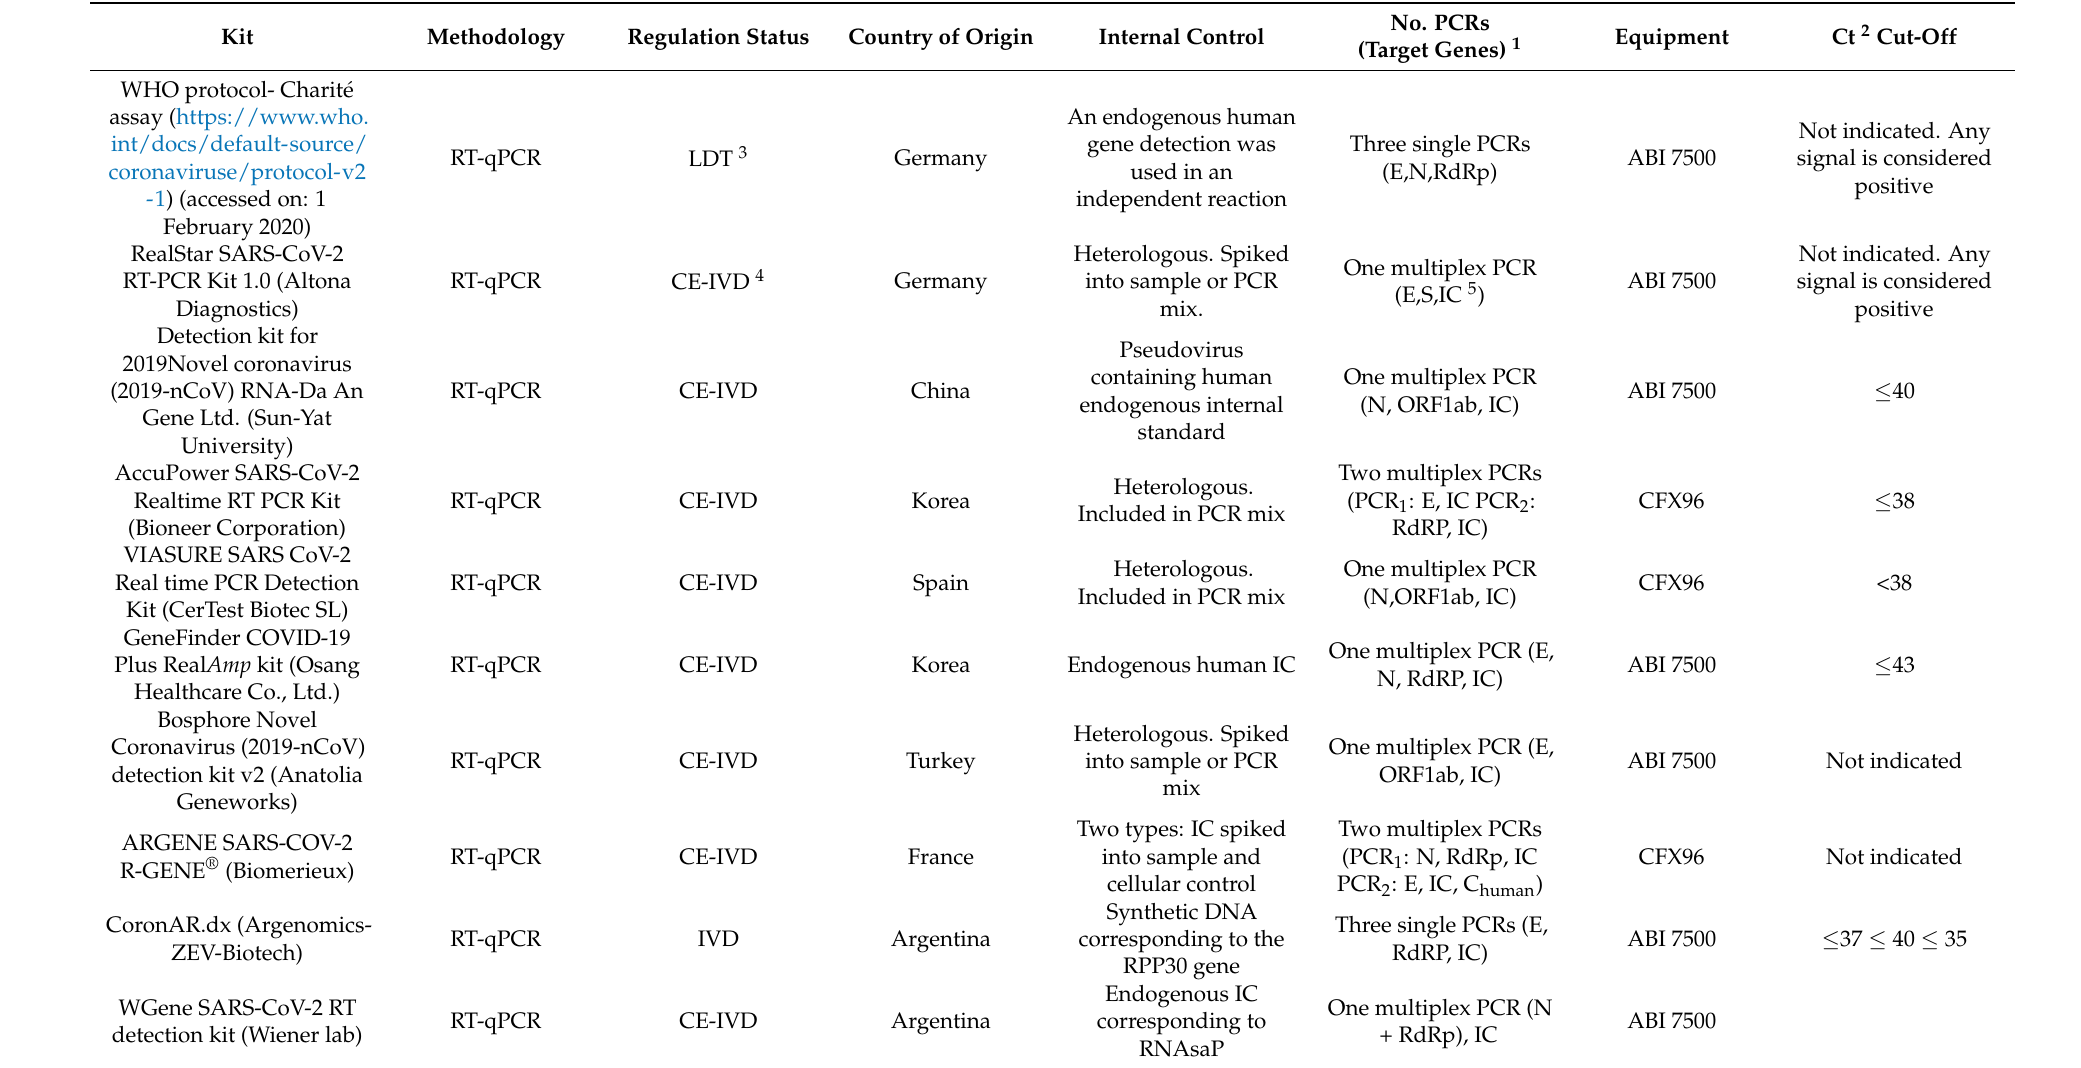
Table 1. Overview of the evaluated SARS-CoV-2 detection kits available in